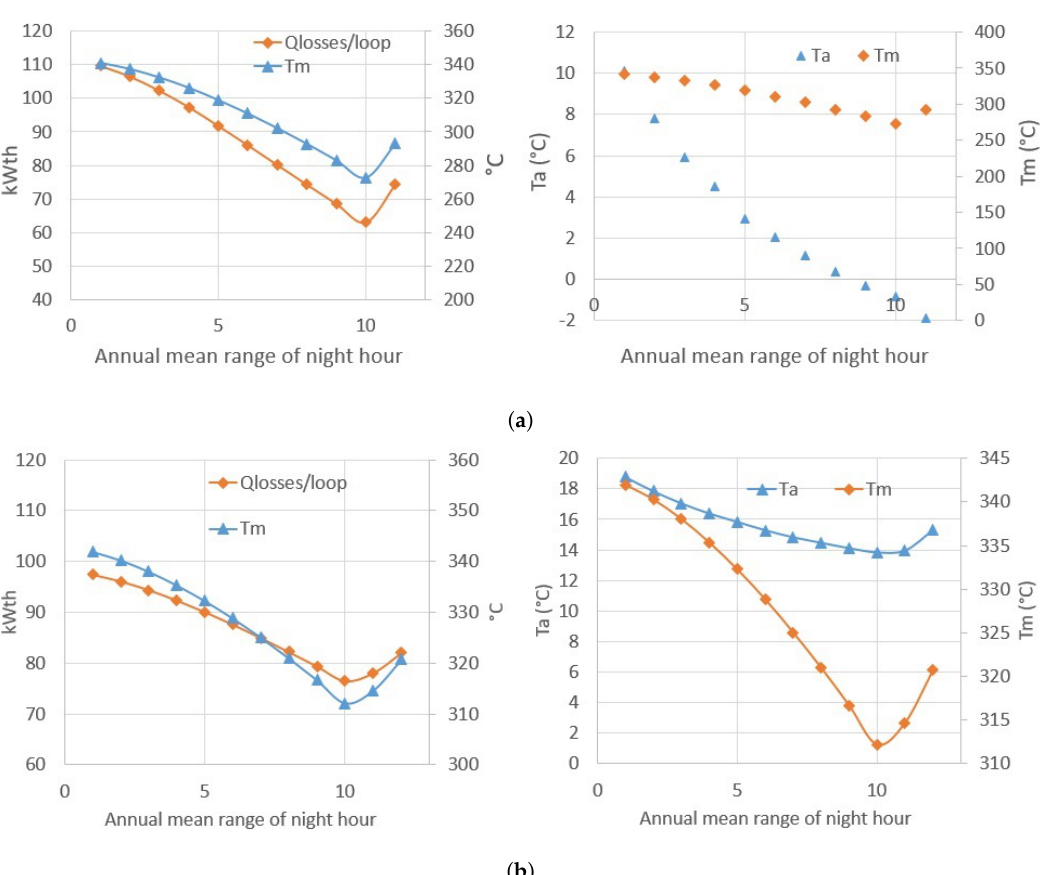
Figure 10. Annual hourly average of the nightly evolution of the mean temperature per loop. ( a ) Site 1 case. ( b ) Site 2